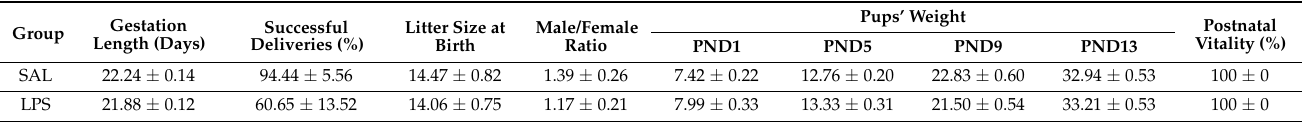
Table 1. Reproduction parameters. The table shows the length of gestation (in days), the % of successful deliveries, the litter size, the male/female ratio, the weight gain of pups and the % of postnatal vitality (Dams: SAL = 9, LPS = 8; Pups: SAL = 19; LPS = 17). Data represent mean ± S.E.M. (Student’s t -test): p = 0.08 vs.